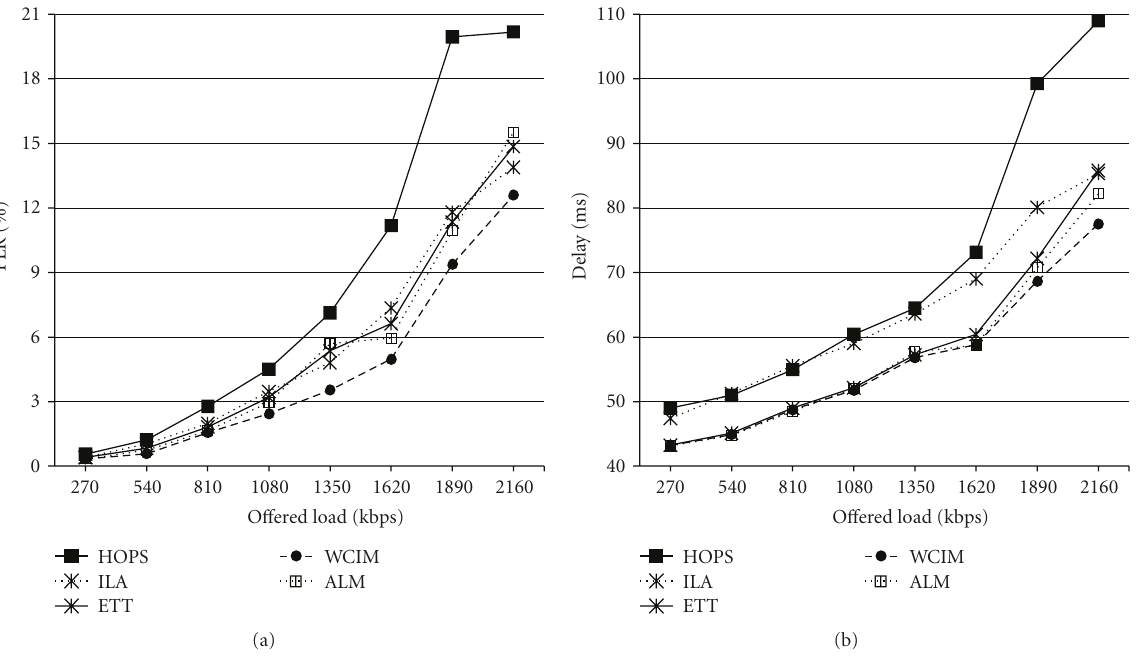
Figure 7: Scenario 2 results. (a) Packet loss rate. (b) End-to-end delay.